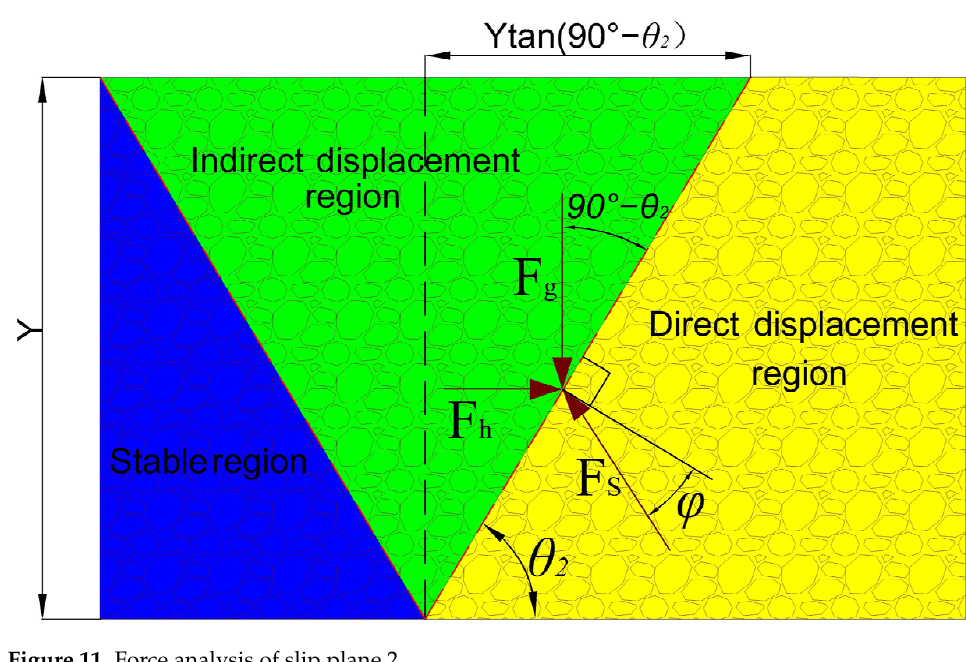
Figure 11. Force analysis of slip plane 2.